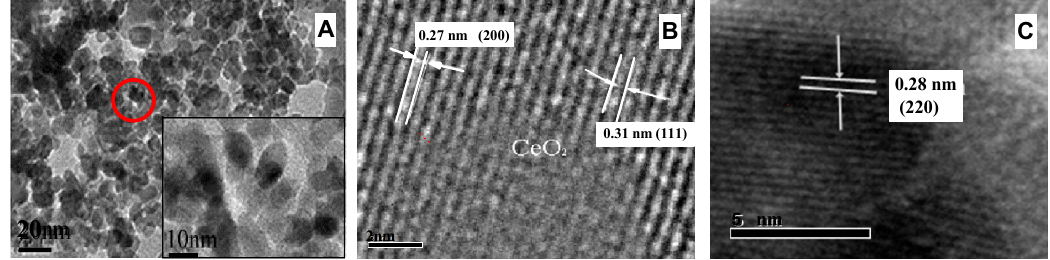
Figure 3. HR ‐ TEM images of ( A ), Co 3 O 4 ‐ CeO 2 catalyst; ( B , C ), enlarged part from (A). Figure 3. HR-TEM images of ( A ), Co 3 O 4 -CeO 2 catalyst; ( B , C ), enlarged part from ( A